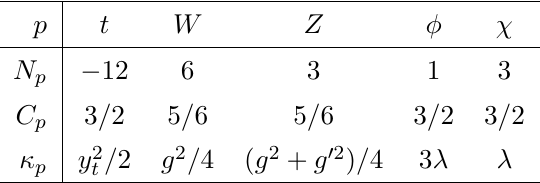
Table 1 . Coefficients for the effective quartic coupling in eq.